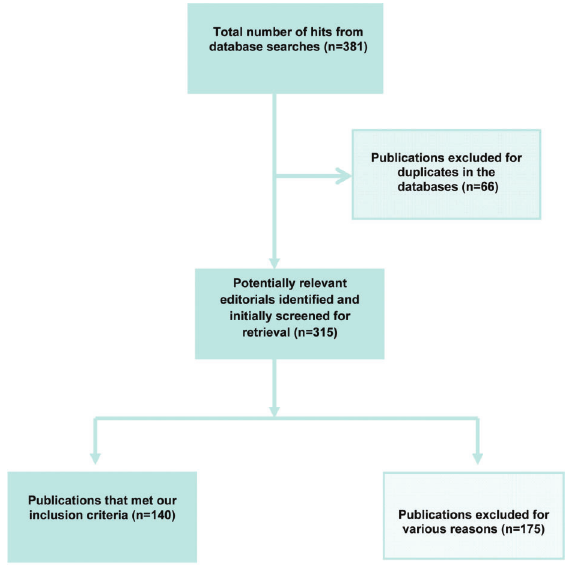
Figure 1. Screening process for the